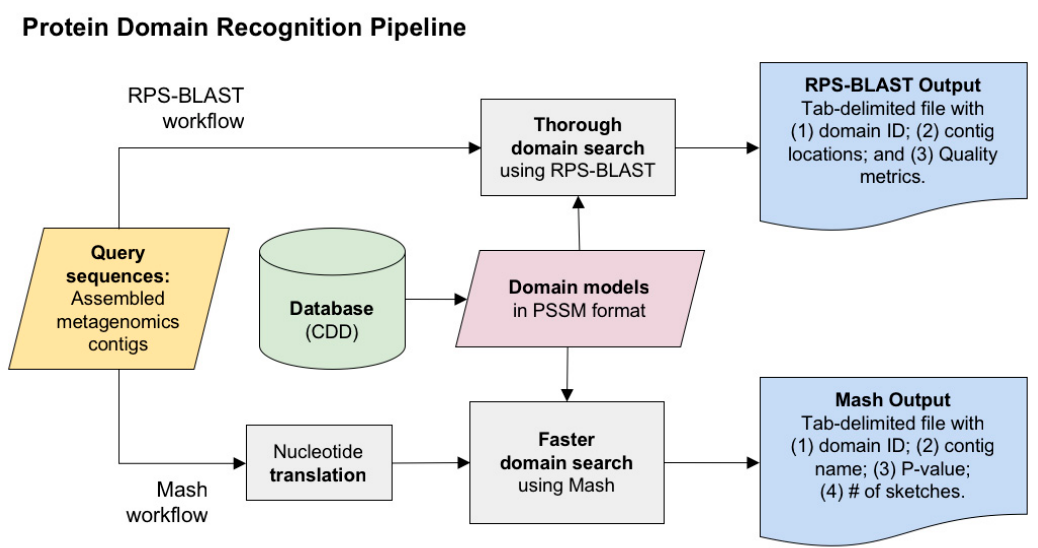
Figure 1. Protein Domain Recognition Pipeline. Using 2082 entries from CDD (Conserved Domains